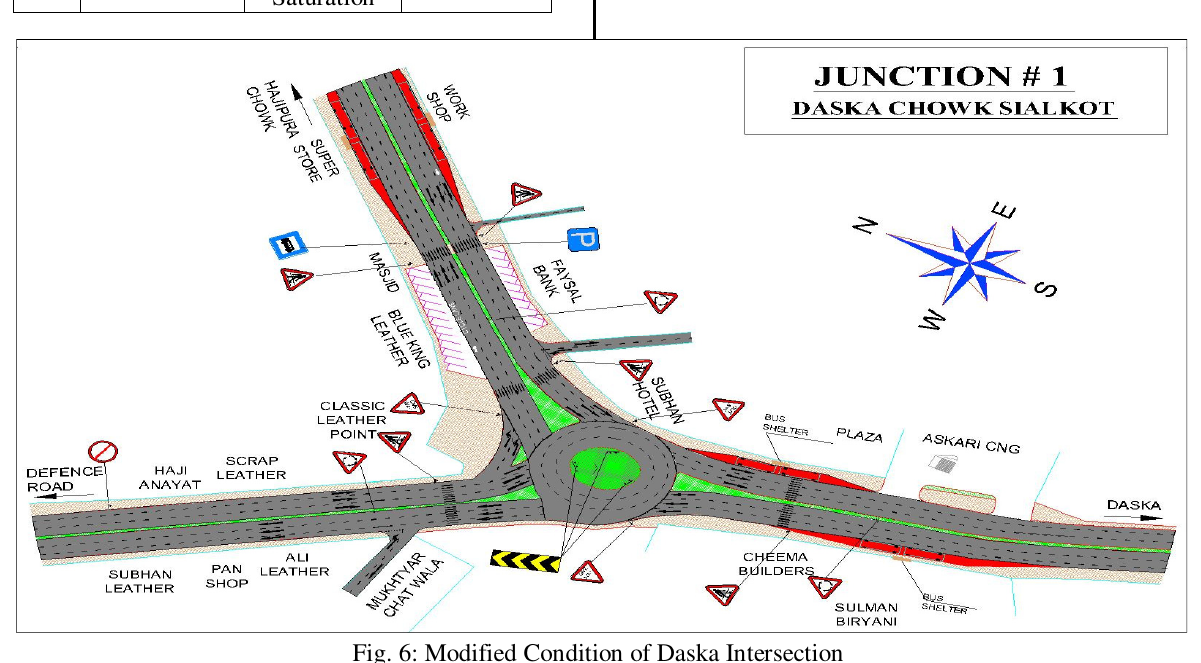
Fig. 6: Modified Condition of Daska Intersection